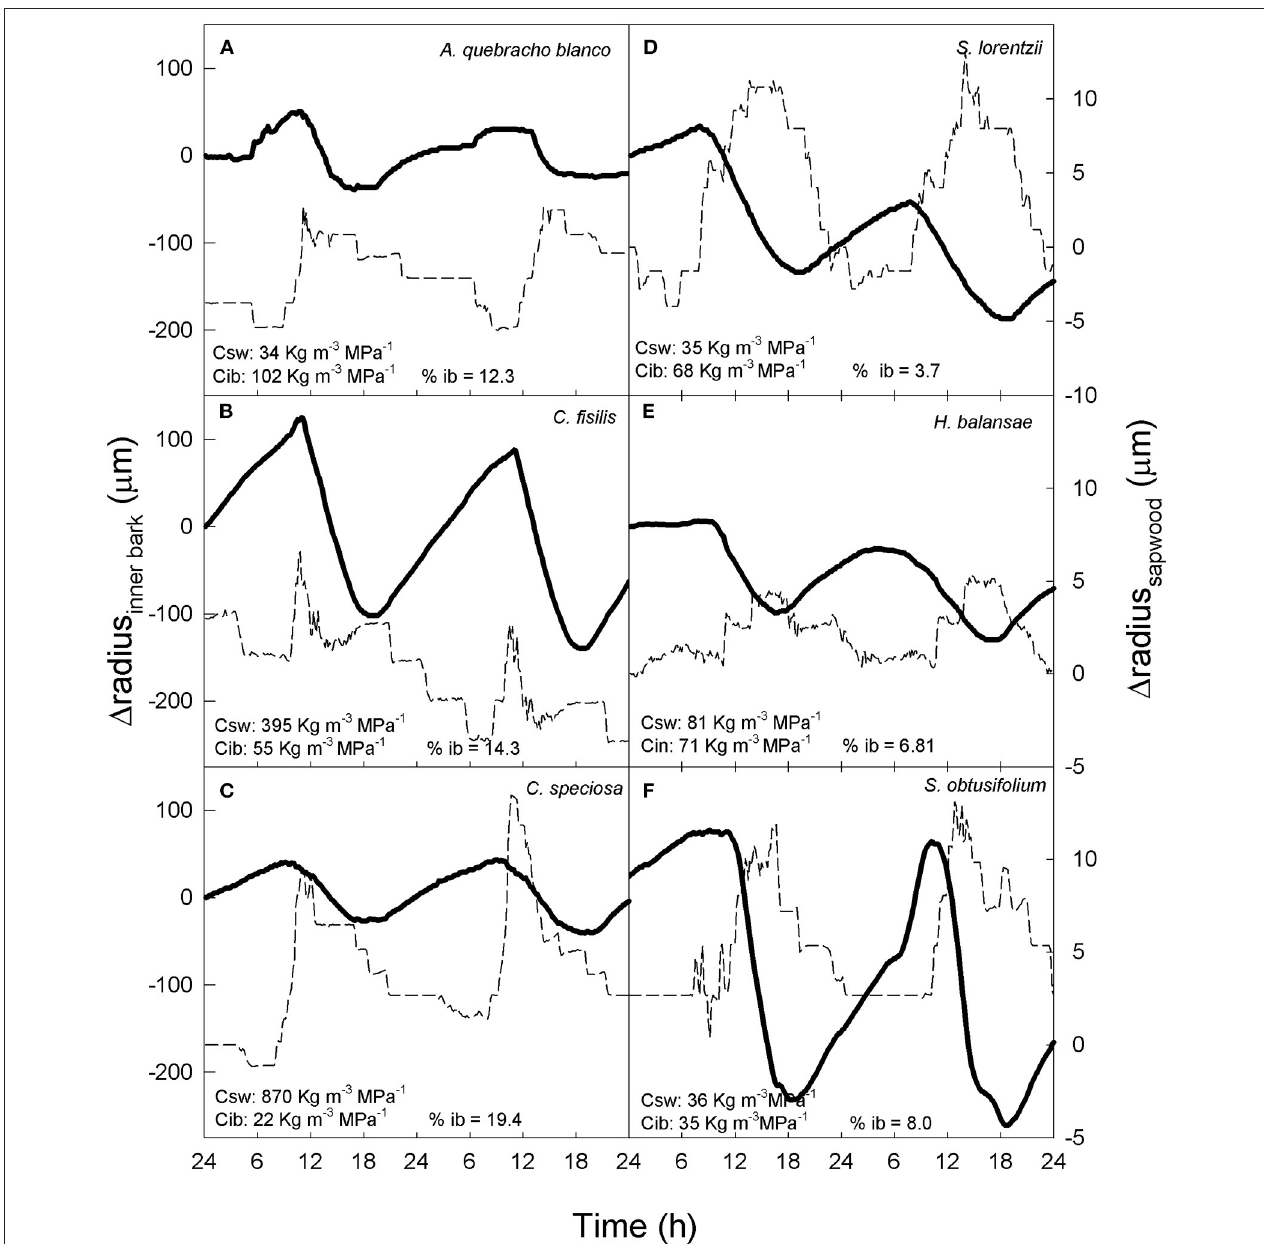
FIGURE 4 | (A–F) Changes in radius of inner bark (solid line) and sapwood (dashed line) in six trees species with different sapwood capacitance (Csw), inner bark capacitance (Cib) and percentage of inner bark (% ib).